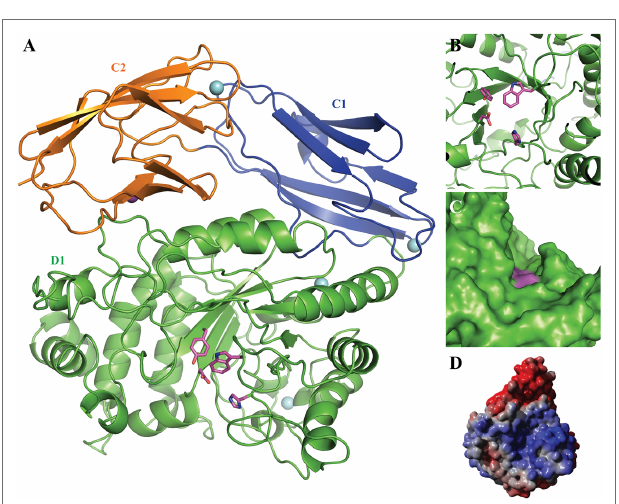
FIGURE 2 | 3D homology model of Fhf2. The putative N-terminal catalytic domain D1 is shown in green with the catalytic residues Asp227 and His297 as well as the conserved Tyr139 and Trp350 highlighted in pink; the C-terminal domains C1 and C2 are presented in blue and orange, respectively. The four predicted Ca 2+ ions are indicated by cyan spheres and the predicted Na + ion by a purple sphere. (A) The 3D model presented as cartoon, showing the beta-barrel fold of the predicted C1 and 2 domains as well as the beta-barrel fold surrounding the active site. (B) A zoom of the active site, nicely illustrating the active site amino acids. (C) A sphere model, showing the grove extending from the active site. (D) Electrostatic surface of the Fhf2 homology model: blue color indicates positively charged surface areas, while red color indicates negatively charged surface